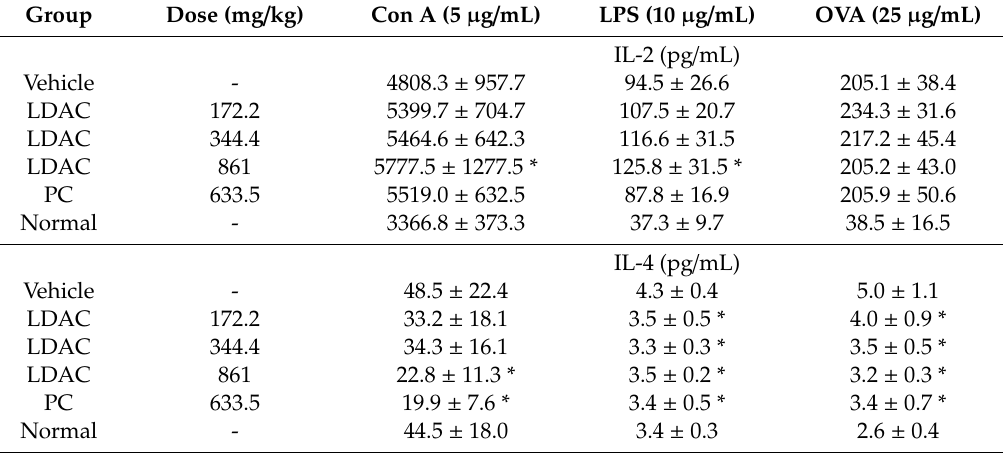
Table 3. E ff ect of LDAC on cytokines secretion in specific immune